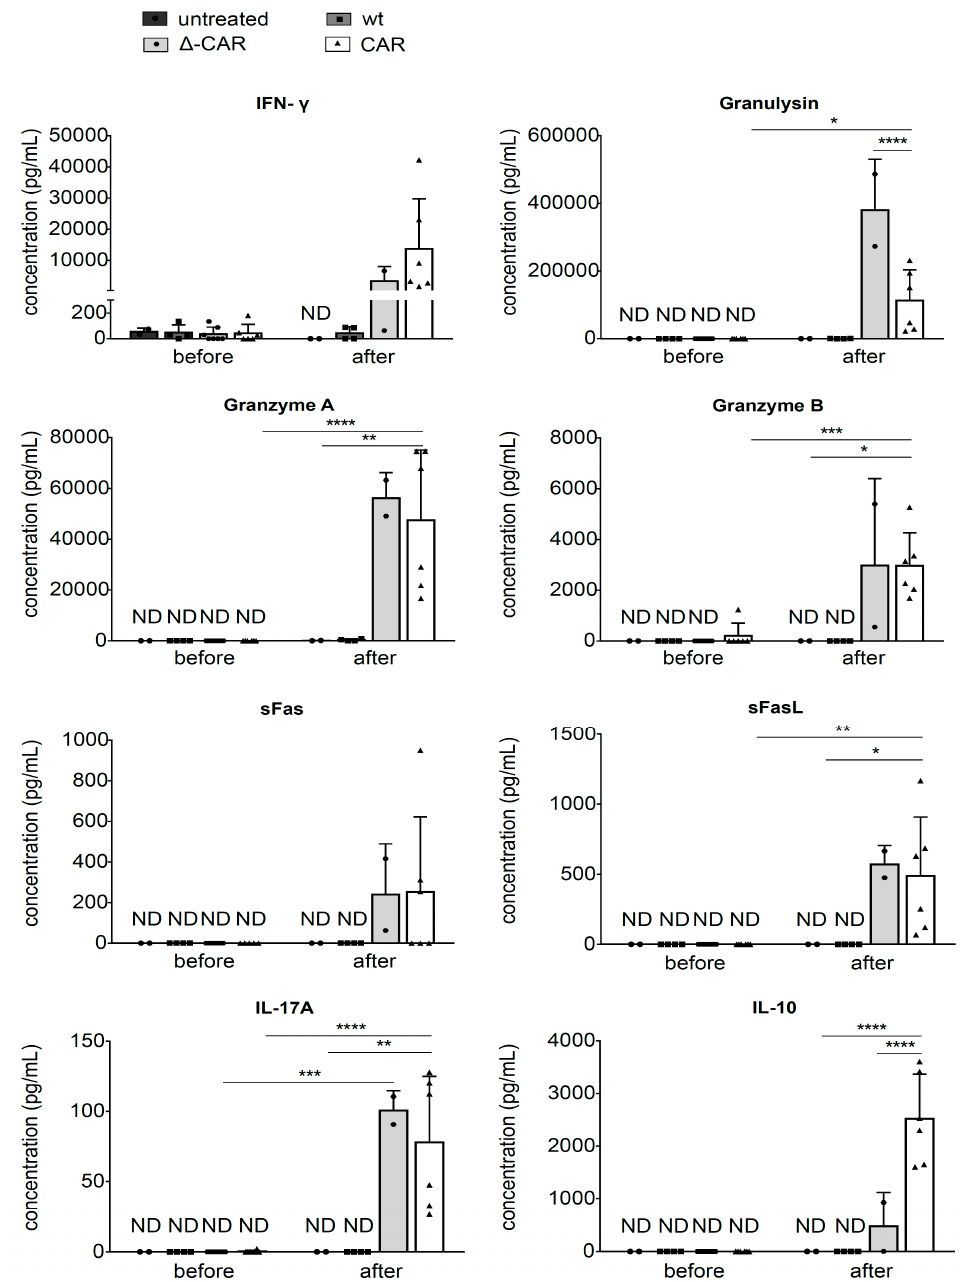
Figure 5. Quantification of secreted cytokines in the peripheral blood samples acquired from the mice analyzed in Figures 3 and 4. Samples were processed according to the LEGENDplex™ human CD8/NK panel multi-analyte flow assay kit protocol and bead acquisition for cytokine quantification was accomplished with a Beckman Coulter Cytoflex flow cytometer. IFN-g, interferon- γ ; sFas, soluble Fas; sFasL, soluble Fas ligand. Each data point represents the average cytokine amount from duplicate measurements of peripheral blood samples of an individual mouse. For measurements before NK cell application, 20 samples were evaluated: n = 2 mice for the untreated group, n = 4 mice for the unmodified (wt) NK-92 cell group, n = 7 for the ∆ -CAR group and n = 7 for the CAR-NK-92 cell group. For measurements at time of sacrifice (after NK-92 treatment), n = 2 mice for the untreated group, n = 4 mice for the unmodified NK-92 cell group, n = 2 for the ∆ -CAR group and n = 6 for the CAR-NK-92 cell group. Bars indicate mean ± SD of cytokine levels from all mice within a group. Two-way ANOVA with Bonferroni multiple comparisons was used to compare cytotoxic activity. Statistically significant differences are indicated by * ( p ≤ 0.05), ** ( p ≤ 0.01), *** ( p ≤ 0.001), **** ( p ≤ 0.0001). ND indicates below the level of